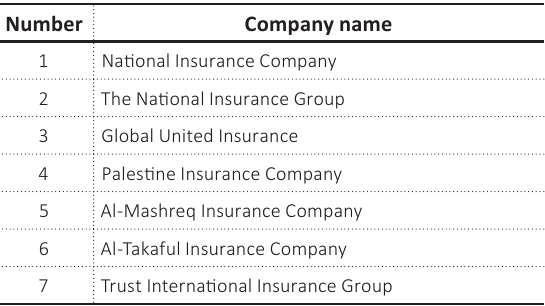
Table 1. Palestinian insurance companies listed